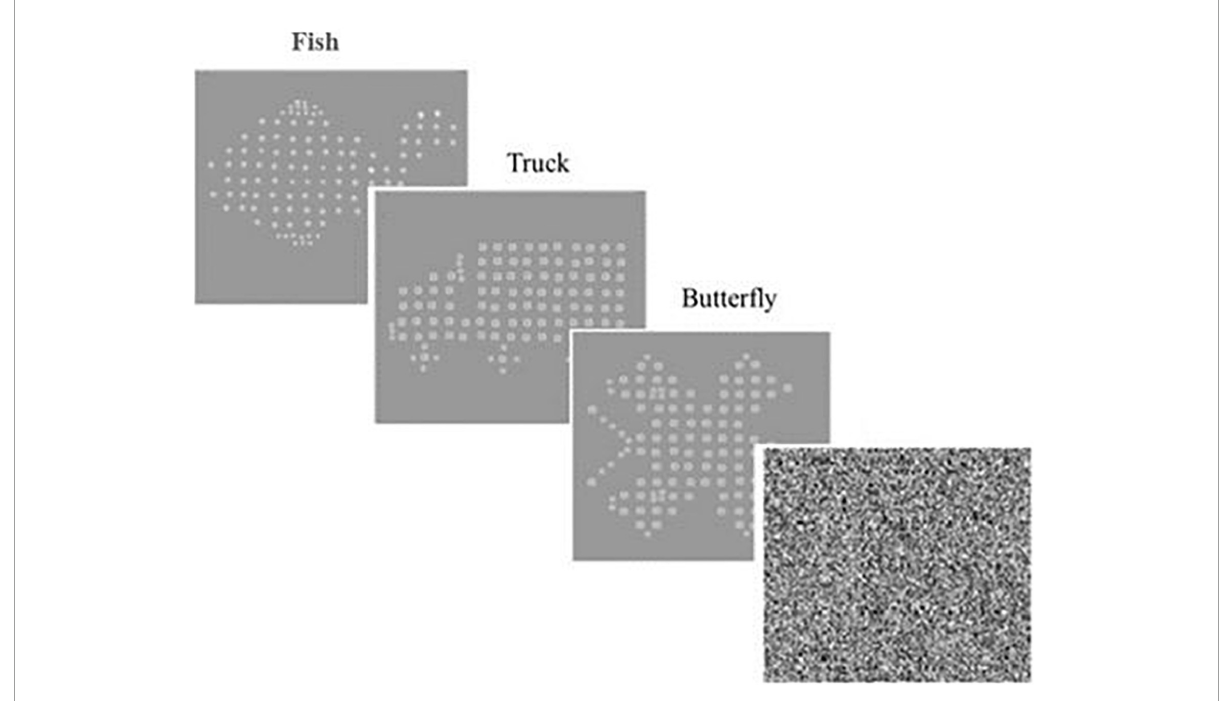
FIGURE4 Inspection time (IT) trials Fish, Truck and Butterfly , only one stimulus presented for each trial.